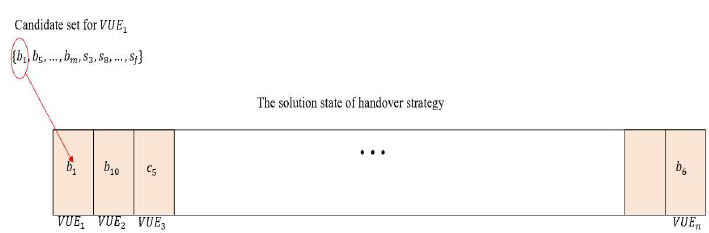
Figure 4. The states of the HC and SA